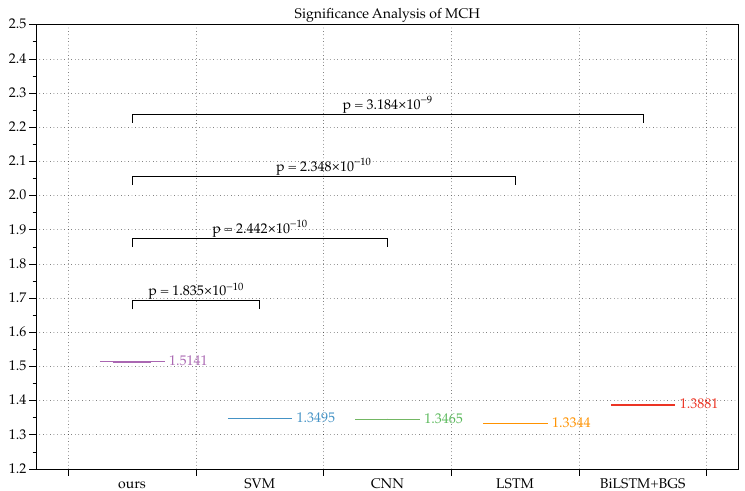
Figure 9. The paired t -test significance analysis of MCH. We compared the group of our MCH values with other four methods. Each group of MCH values was obtained by five runs of the corresponding